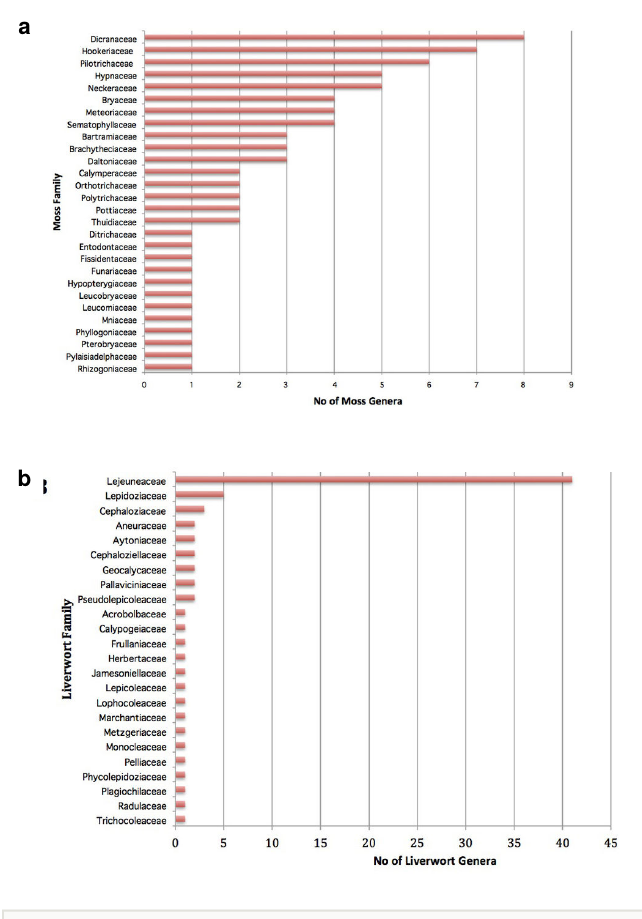
Composition of bryophyte genera by families at Nectandra Reserve, ( A ) moss families (74 genera) and ( B ) liverwort families (75